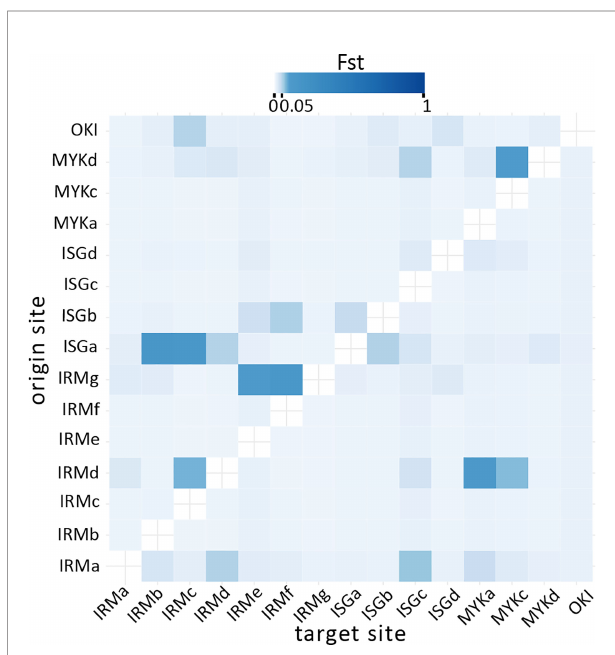
FIGURE 6 | Bayesian assignment test identi fi ed contemporary migration patterns in the Ryukyu Archipelago with posterior mean migration rates ( m = 0.01 implying that 1 individual among a sample of 100 per generation is a migrant). The majority of site pairs showed lower m values (x-axis: target sites, y-axis: origin sites), and a few with higher, sporadic migration